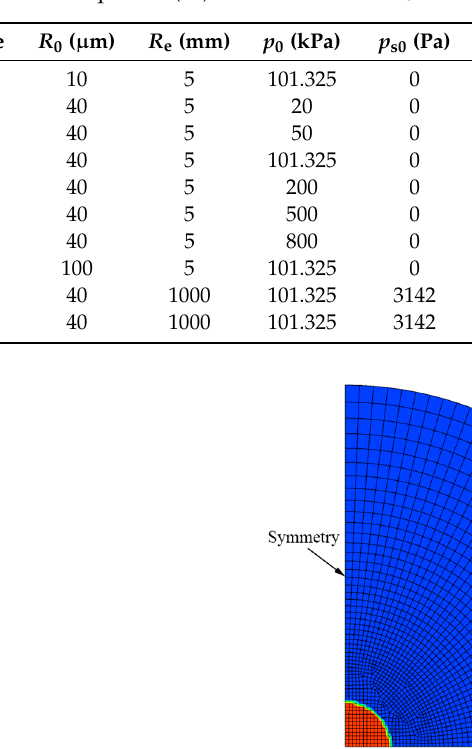
Table 1. Parameters for the validation cases of the spherical bubble triggered by the negative pressure pulse in Equation (22) at the distance of R e .